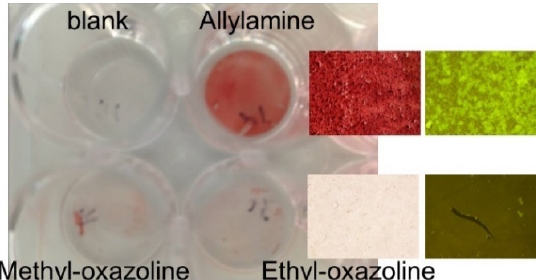
Figure 2. Growth of S. epidermidis for 24 h on glass coverslips coated with allylamine, 2-methyl-2-oxazoline and 2-ethyl-2-oxazoline. While biofilm readily forms on allylamine coated surfaces, a complete inhibition of biofilm growth is seen when the same type of substrate is coated with either 2-methyl-2-oxazoline or 2-ethyl-2-oxazoline. The microscopy images confirm the macroscopic observations.